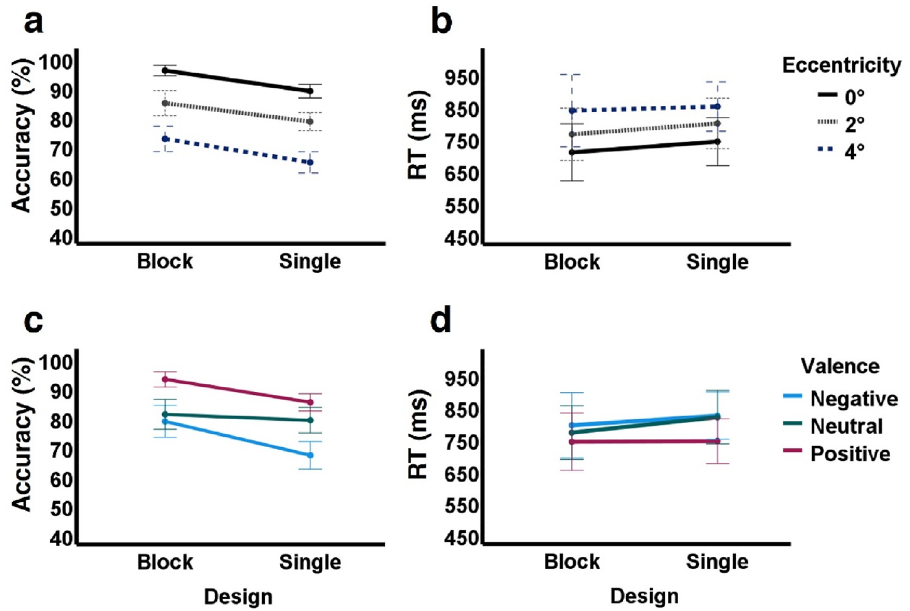
Figure 3. Block-design vs single-trial within-participant accuracy and reaction time comparisons (n = 32). ( a , b ) Design by eccentricity interaction plots for accuracy ( a ) and RTs ( b ); ( c , d ) design by valence interaction plot for accuracy ( c ) and RTs ( d ). These direct between-experiment comparisons revealed single-trial accuracy was significantly lower than that of the block-design experiment (possibly reflecting spatiotemporal summation) but no RT differences were found. See “Results” section and Table 3 for more